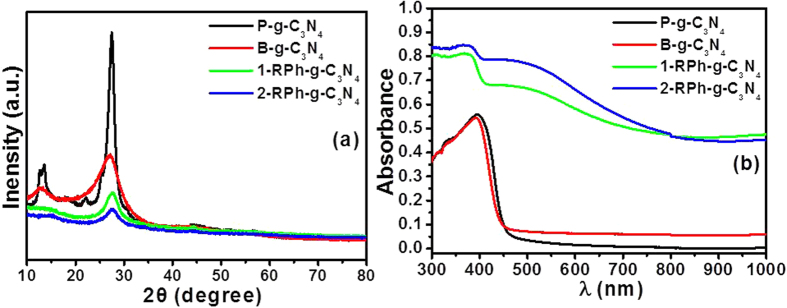
(a) XRD patterns and (b) UV-visible diffuse absorbance spectra of P-g-C3N4, B-g-C3N4, 1-RPh-g-C3N4, and 2-RPh-g-C3N4 heterostructure.